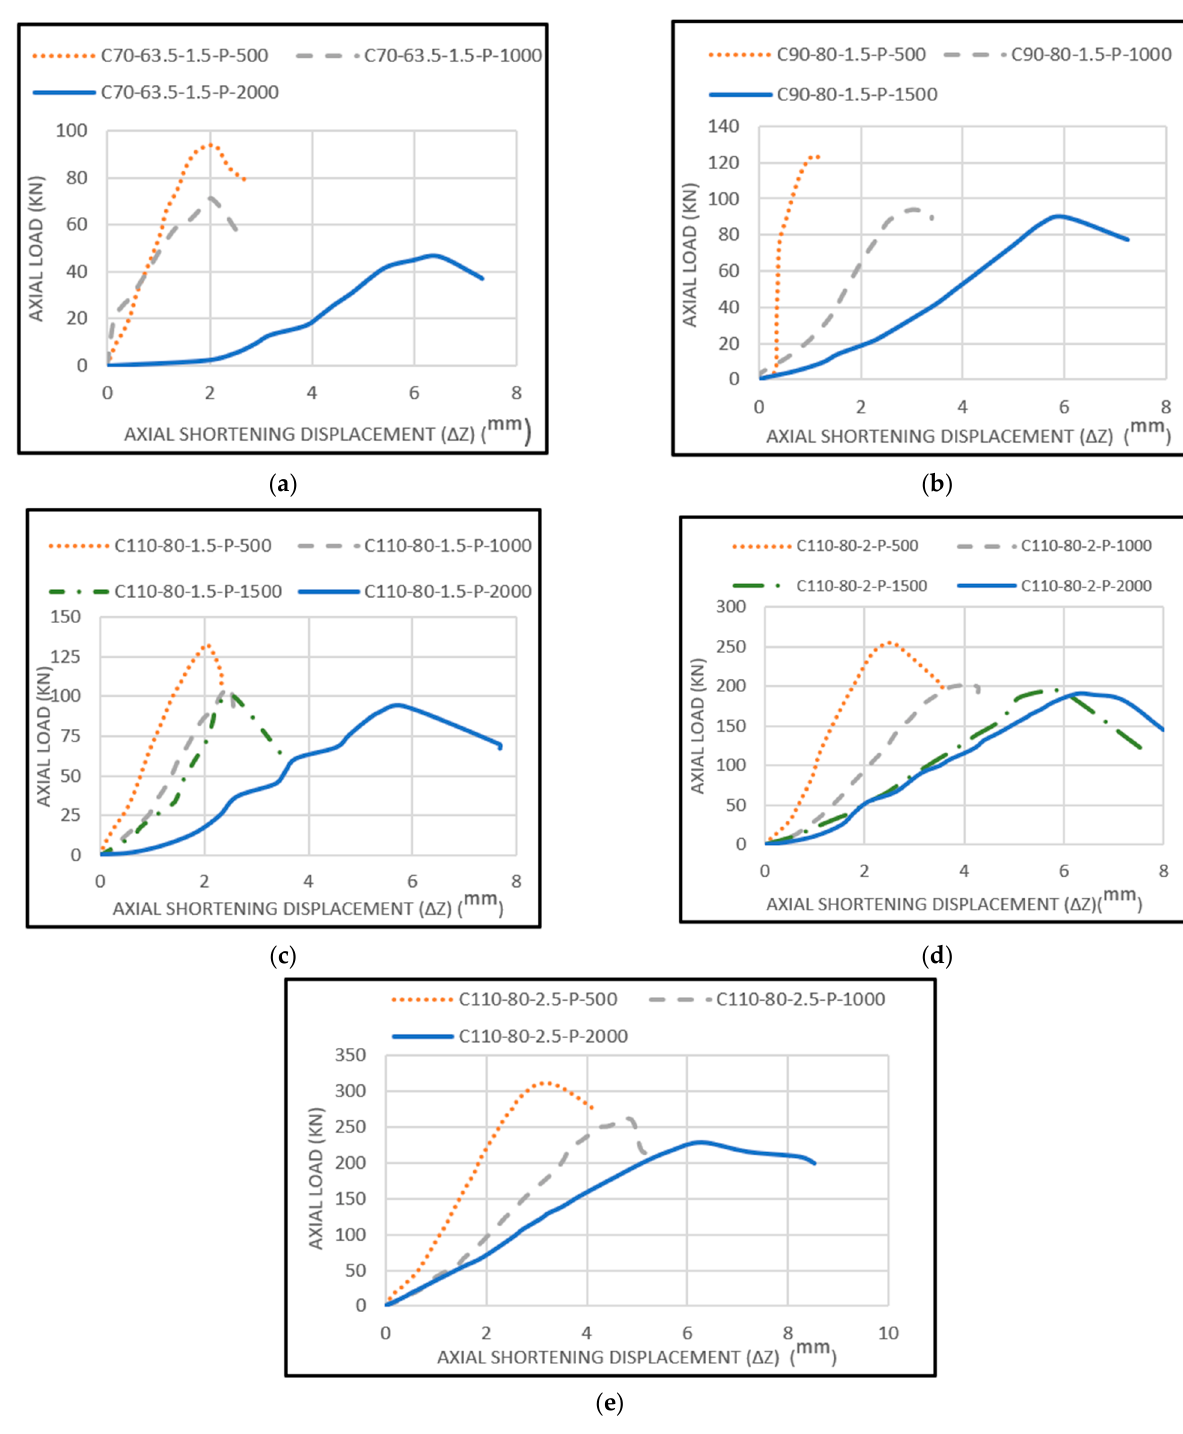
Figure 4. The load ‐ axial shortening–displacement curves. ( a ) Section type (C70 ‐ 63.5 ‐ 1.5 ‐ P); ( b ) Sec ‐ Figure 4. The load-axial shortening–displacement curves. ( a ) Section type (C70-63.5-1.5-P); ( b ) Section tion type (C90 ‐ 80 ‐ 1.5 ‐ P); ( c ) Section type (C110 ‐ 80 ‐ 1.5 ‐ P); ( d ) Section type (C110 ‐ 80 ‐ 2 ‐ P); ( e ) Section type (C90-80-1.5-P); ( c ) Section type (C110-80-1.5-P); ( d ) Section type (C110-80-2-P); ( e ) Section type type (C110 ‐ 80 ‐ 2.5 ‐ P).